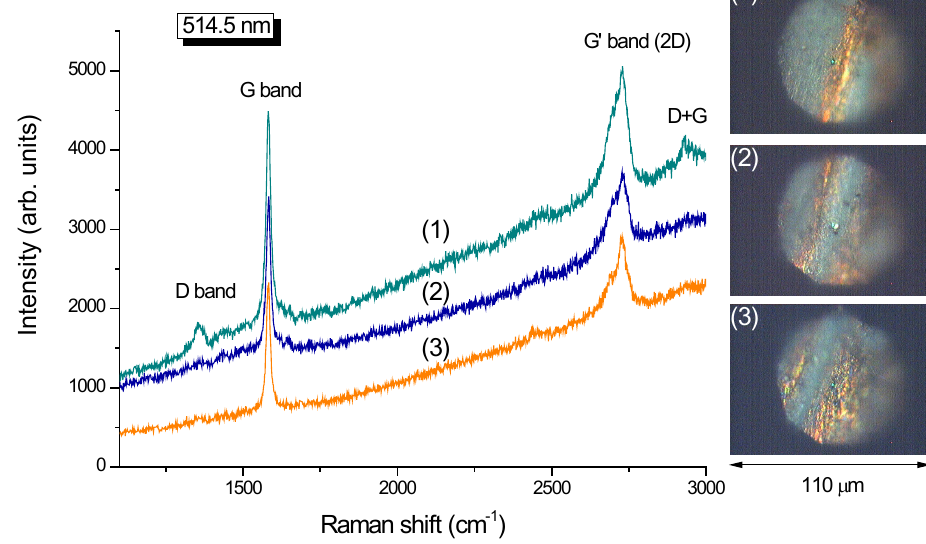
Figure 3. Micro-Raman spectra and corresponding optical images at different points on the copper